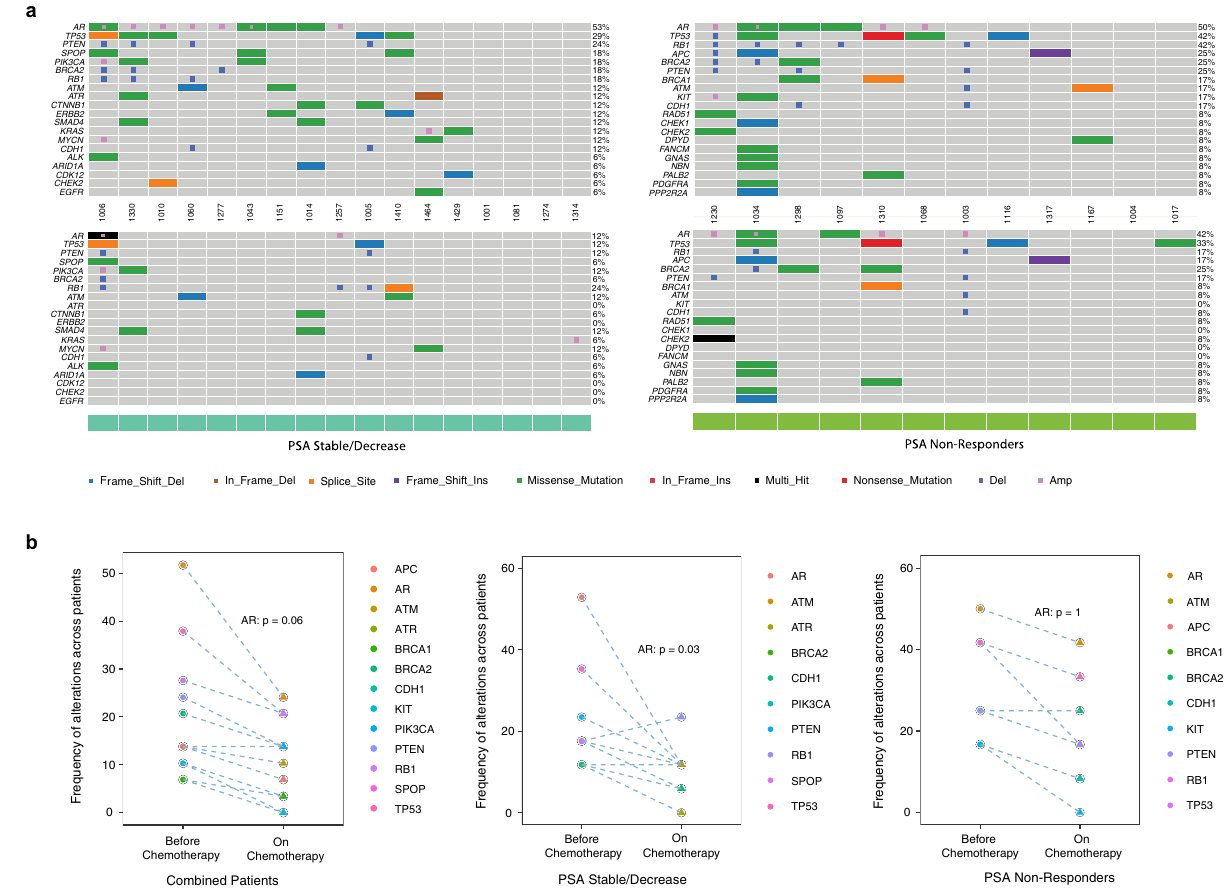
Figure 2. Pharmacodynamic changes in genomic alterations in response to chemotherapy. ( a ) Heatmaps of somatic alterations detected in paired mCRPC samples collected before (top) and after (bottom) 3–4 cycles of chemotherapy from patients who were classified for response to chemotherapy on the basis of PSA levels at the time of second sample collection. Patients exhibiting stable or decreased PSA levels were classified as “PSA Stable/Decrease” and patients exhibiting increased PSA levels as “PSA Non-Responders”. The frequency of alterations observed in a given gene across all patients is listed to the right of the heatmaps. ( b ) Graphical representation of heatmap data for the top 10 most frequently altered genes across all paired patients combined (n = 29), patients with stable or decreasing PSA (n = 17) and patients with increasing PSA levels (n = 12) before and after 3–4 cycles of chemotherapy. The frequency of alterations detected in the AR gene was significantly reduced after chemotherapy in the group of patients with stable/decreasing PSA ( p = 0.03). Comparisons were made using the McNemar’s test with significance set at p ≤ 0.05. The heatmaps in this figure were created by manuscript authors using the Bioconductor ComplexHeatmap software package (version 3.14) (https:// www. bioco nduct or. org/ packa ges/ relea se/ bioc/ html/ Compl exHea tmap.